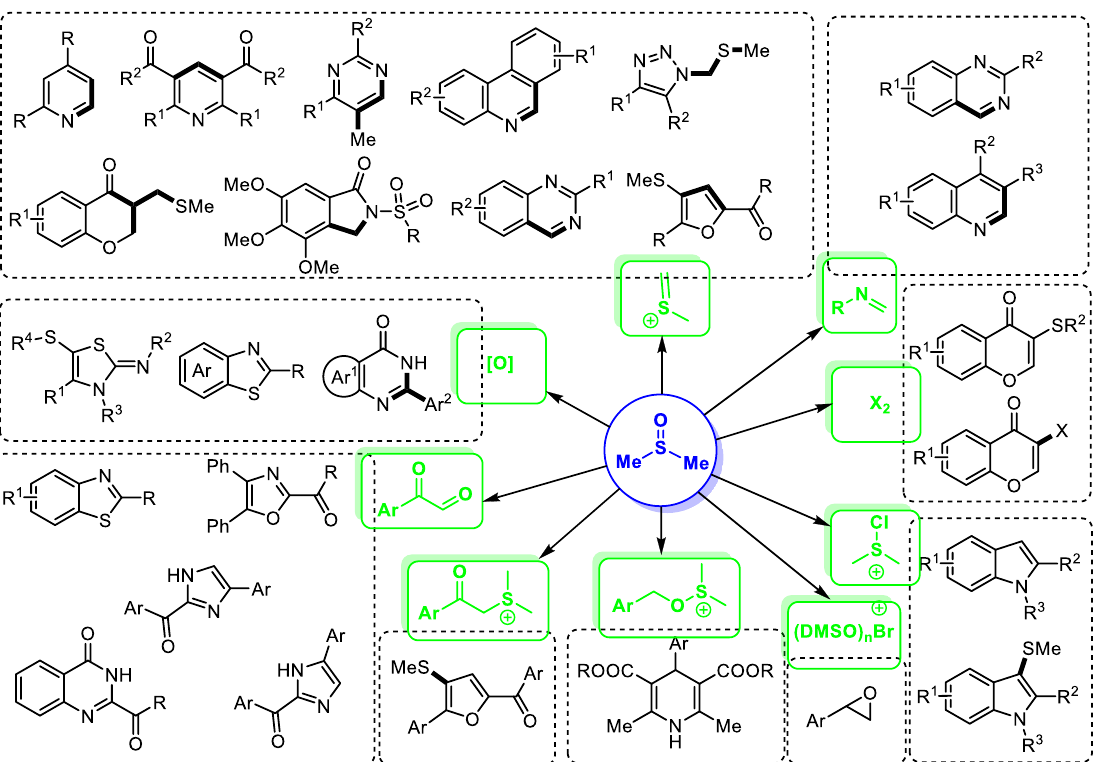
Figure 1. DMSO-based direct synthesis of